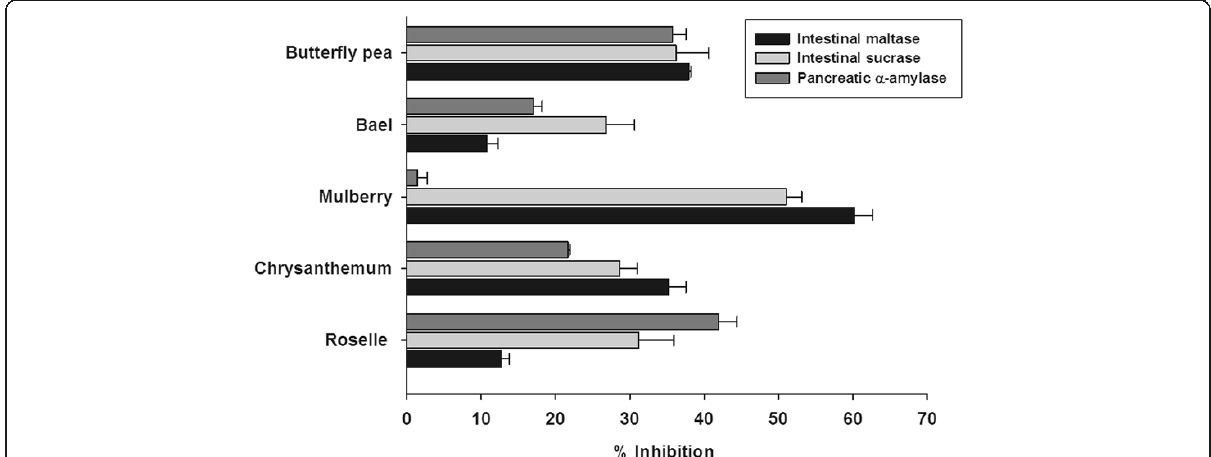
Figure 1 The inhibitory effect of five plant-based foods on intestinal glucosidase (1 mg/ml) and pancreatic α -amylase (2.5 mg/ml). The results are expressed as means ± S.E.M., n=3.